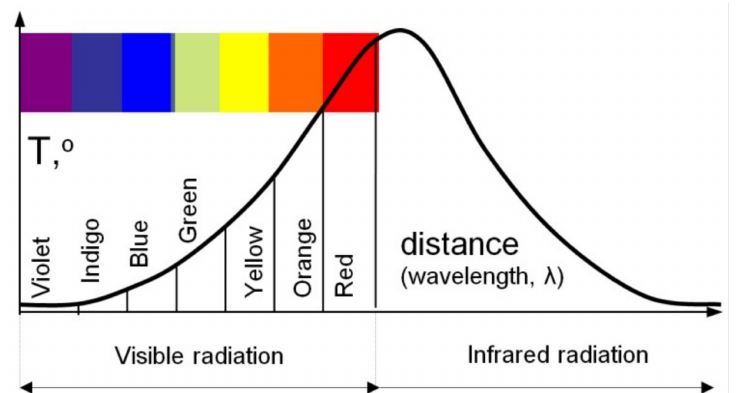
Figure 2. Distribution curve of temperatures indicated by thermometers placed in different colours of the solar spectrum, obtained in the Herschel’s experiment; the notation T ◦ indicates degrees of temperature T not further defined in his article [8].